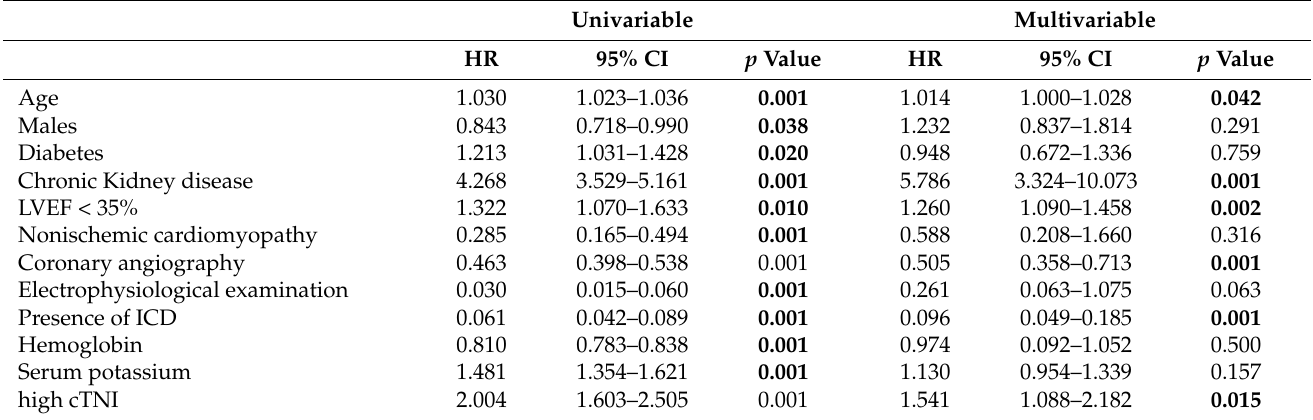
Table 4. Uni- and multivariable Cox regression analysis with regard to 30-day all-cause mortality (primary